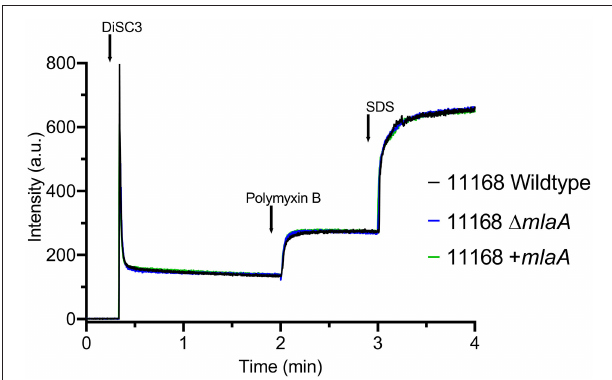
FIGURE 2 | Membrane permeability of the C. jejuni 11168 wild-type strain, isogenic mlaA deletion mutant ( 1 mlaA ), and complemented ( + mlaA ) strain. Permeability of intact cells was measured using the fluorescent probe 3,3’-Dipropylthiadicarbocyanine Iodide (DiSC3) which accumulates on, and translocates into, hyperpolarized lipid bilayers. Cells were washed prior to the assay, removing OMVs, to measure parent cell membrane permeability. Polymyxin B was added to the cells at a final concentration of 100 µ M and release of DiSC3 from the membrane was measured. SDS was added at a final concentration of 20mM to measure maximum